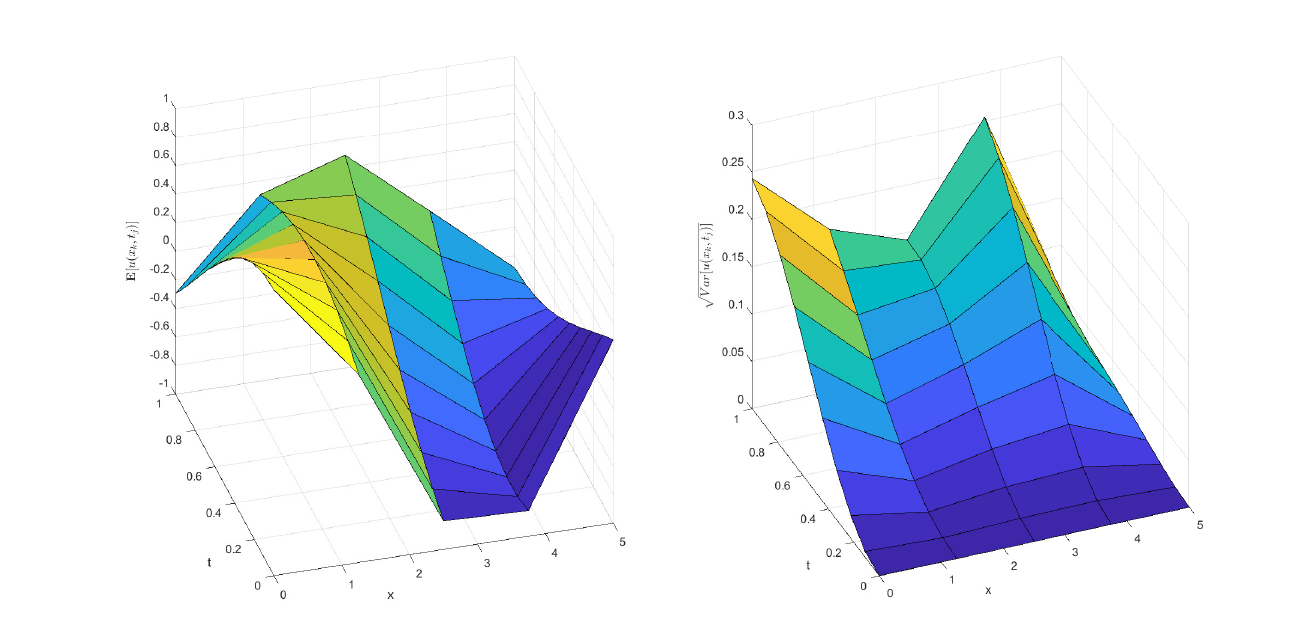
Figure 5. Expectation and variance of the exact solution for the random hyperbolic partial differential equation (PDE) (25) with a ∼ N ( 2,0.25 ) , b , c ∼ Beta ( 2, 5 ) , performed using the Monte-Carlo method with N MC = 10 3 simulations. Table 5. Comparison of various methods of numerical integration for the random hyperbolic